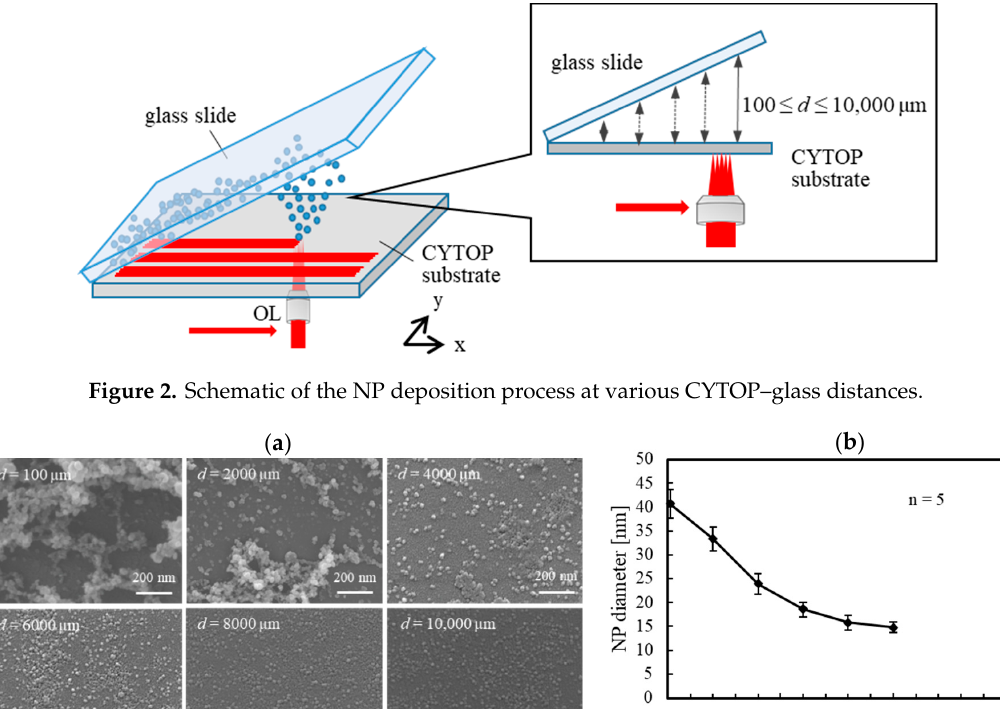
Figure 2. Schematic of the NP deposition process at various CYTOP–glass distances.